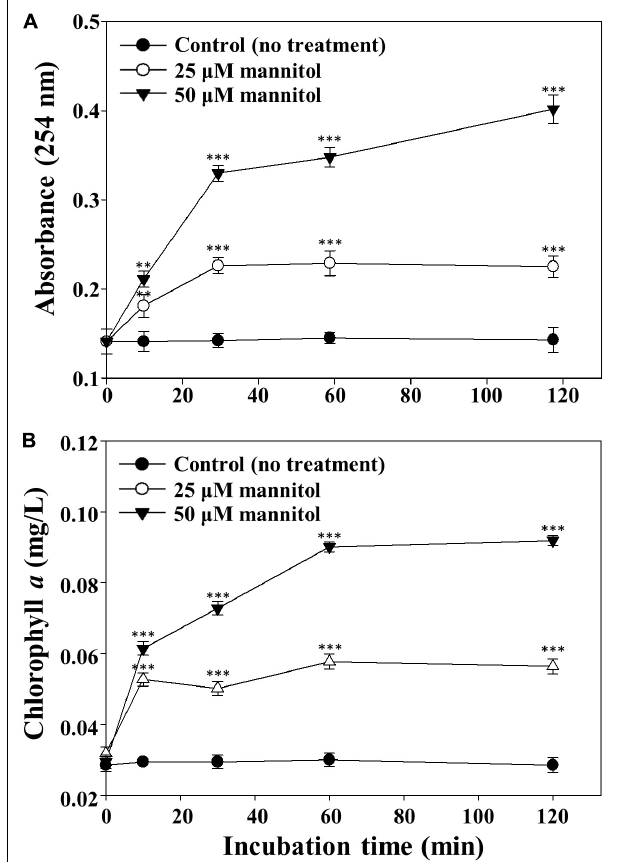
FIGURE 6 | Concentration profiles of intracellular organic matter (A) and chlorophyll a (B) released from Microcystis aeruginosa NIES-298 cells treated with mannitol. After mannitol treatment, cell cultures were filtered using a 0.45- µ m syringe filter and the concentrations of organic matter (254 nm) and chlorophyll a in the filtrates were measured. Data are indicated as mean values ± standard deviations. Statistical significances depending on the mannitol treatments were calculated compared to the control group (no treatment) and their significant differences were indicated with p -values < 0.01 ( ∗∗ ) or < 0.001 ( ∗∗∗